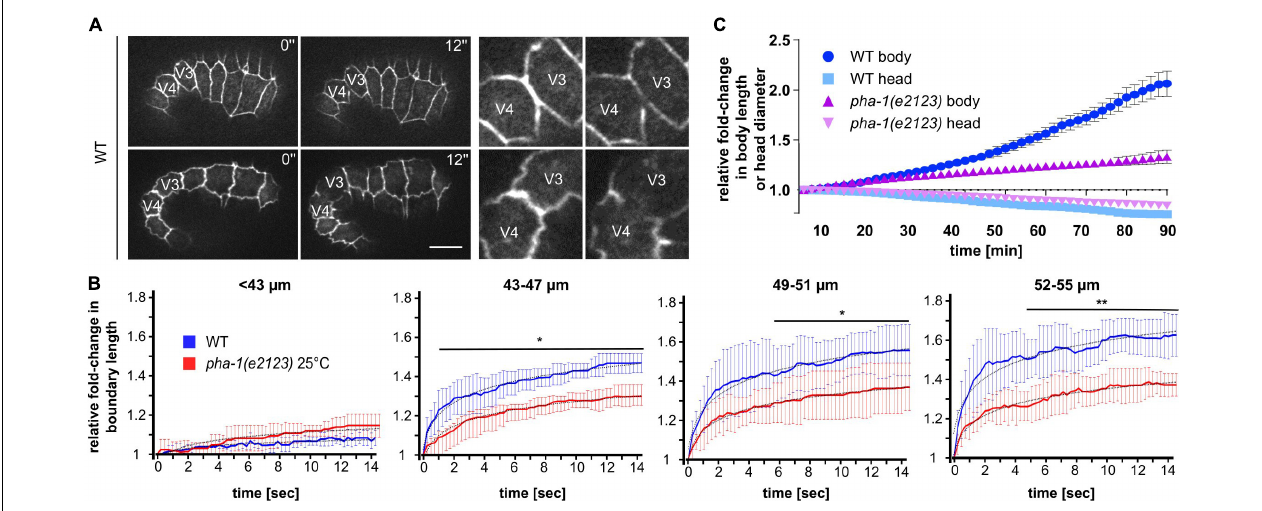
FIGURE 5 | pha-1(e2123) mutants exhibit reduced cell bond tension and elongation. (A) Maximum projected stills from time-lapse microscopy of laser-ablated WT embryos expressing DLG-1::dsRed at different stages of elongation. Laser ablation was performed at the cell boundary between V3 and V4. Left: total view of embryos; right: detailed view of ablated cell boundaries. Scale bar, 10 µ m. (B) Normalized quantification of recoil of V3/V4 cell boundaries post-ablation for WT and pha-1(e2123) embryos of varying length ( ≤ 55 µ m, length: anterior side of H0 – posterior side V5), (with SD, n = 5 each, start = 1). (C) Comparison of changes of head diameter in proportion to embryonic body length over time for WT and pha-1(e2123) embryos (with SEM, n = 4 each, start length = 1). T-test: * p < 0.05; ** p <